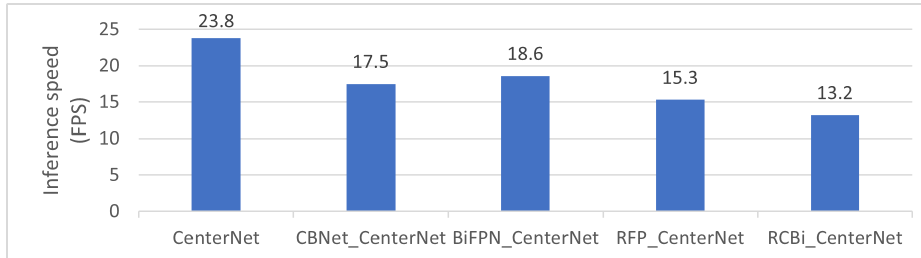
Figure 10. Inference